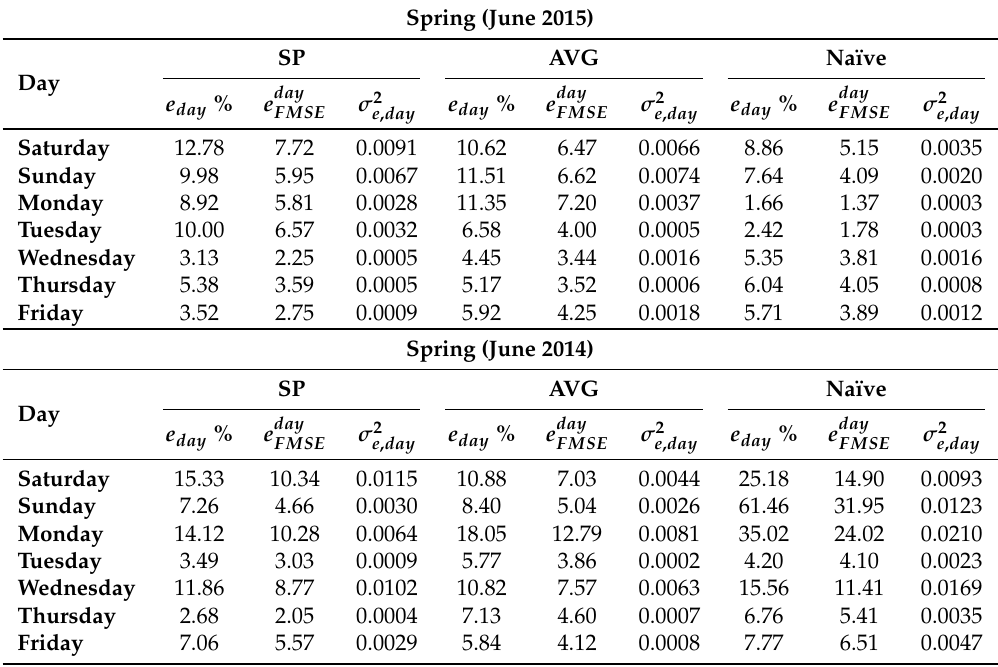
and σ 2 of summer of 2016, 2015 and 2014 for the SP model, average FMSE e , day